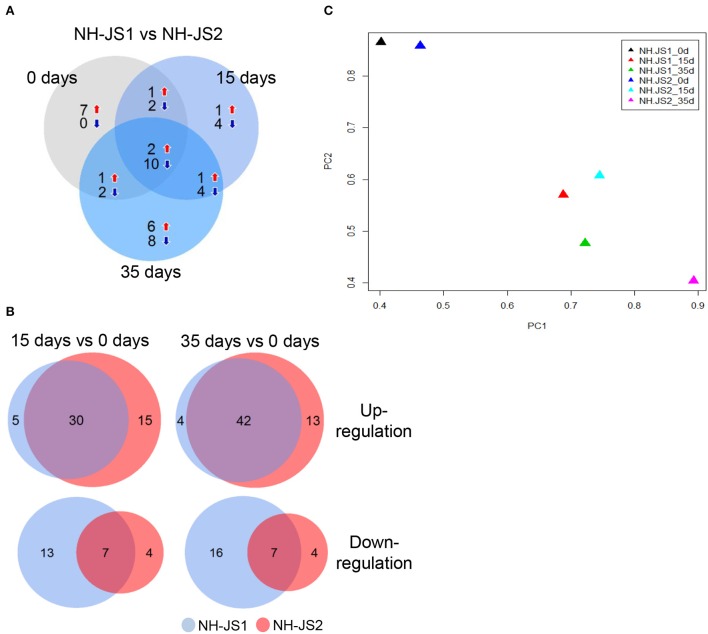
Comparison of flowering-time genes differentially expressed between two inbred lines under vernalization conditions. (A) Differentially expressed genes (DEGs) compared between the two inbred lines at each vernalization time (0, 15, and 35 days). (B) Comparisons of flowering-time DEGs between 15 and 0 days, and between 35 and 0 days, in the two inbred lines. Red and blue arrows indicate up-regulation and down-regulation, respectively. Numbers indicate genes differentially expressed in NH-JS1 relative to NH-JS2. (C) Principle component analysis of flowering-time DEGs between two inbred lines in the normal and vernalization conditions. Each color of triangle corresponds to a different time point in the two inbred lines. The largest variation between NH-JS1 and NH-JS2 was observed at 35 days of vernalization.